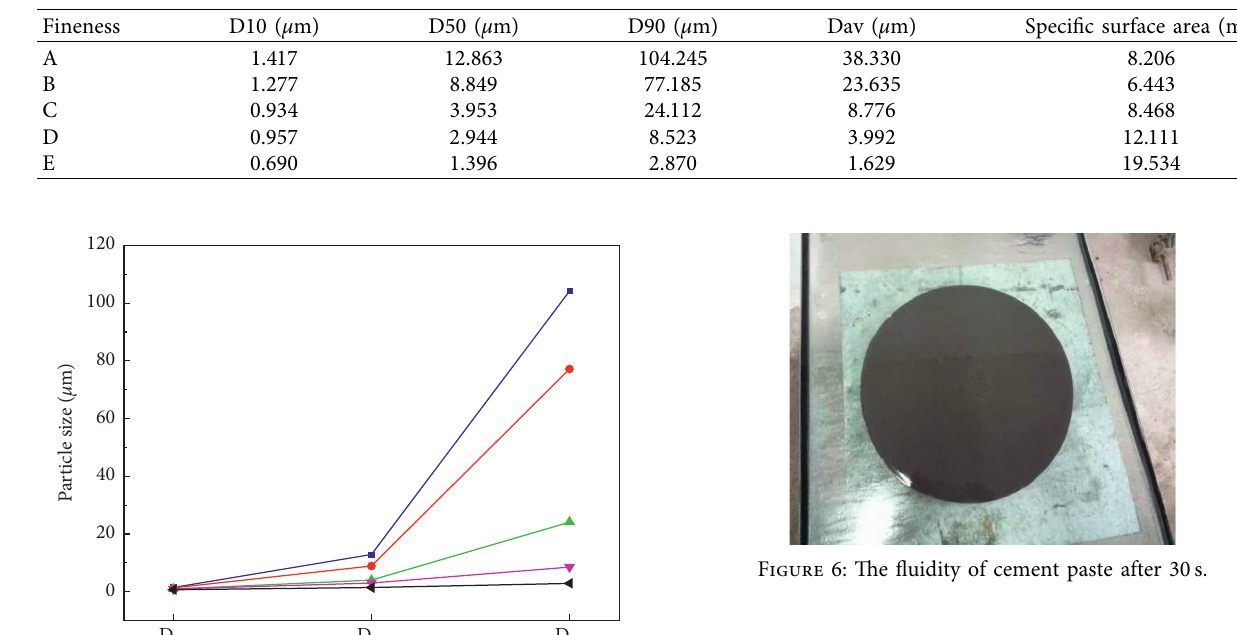
Table 6: Particle size distribution and specific surface area of PPA with different fineness.